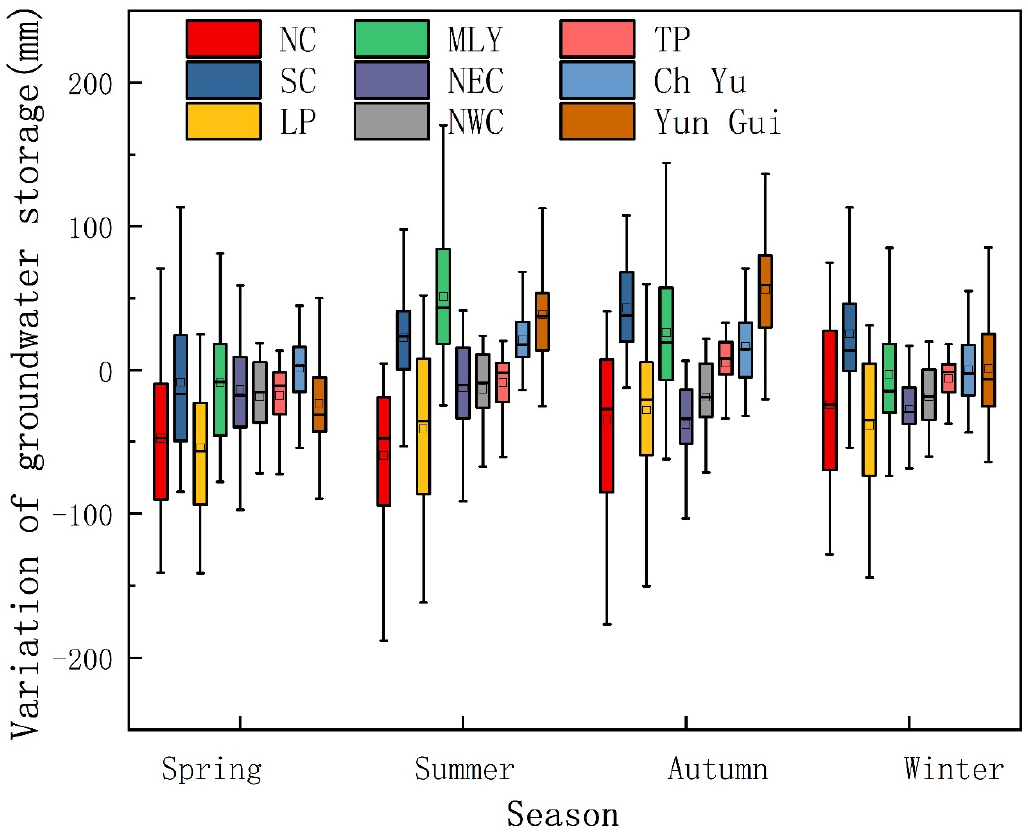
Figure 4. Seasonal changes in groundwater storage in nine regions. The groundwater storage in nine regions was counted for four seasons in each year. Finally, the changes in groundwater storage in spring, summer, autumn, and winter for 17 years are plotted as box-line diagrams. Table 1. Seasonal changing rate of groundwater storage in nine regions (mm y − 1 ).